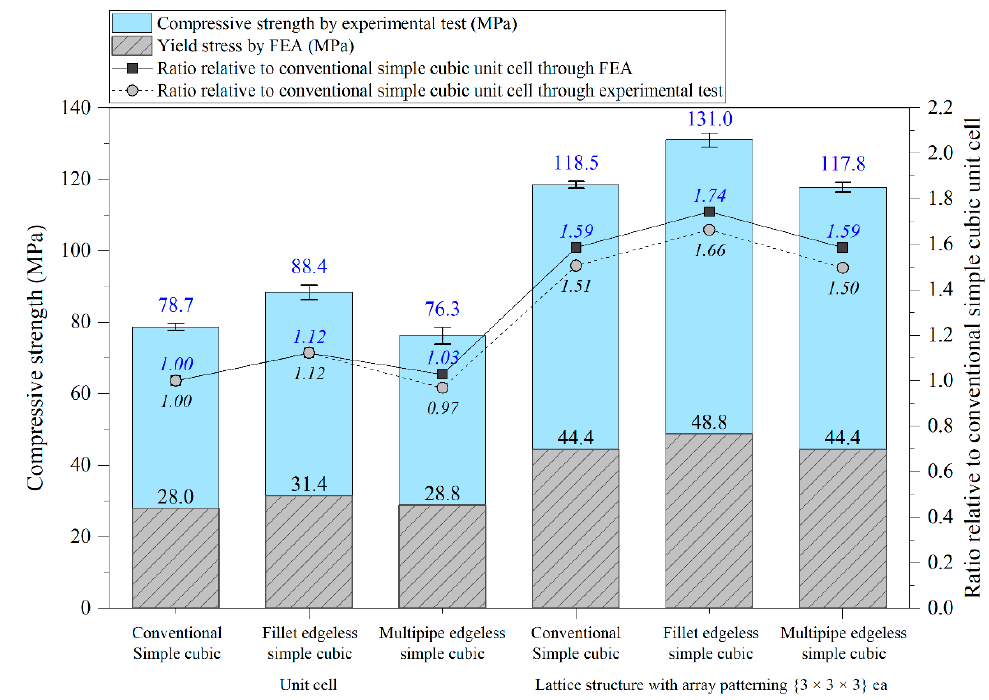
Figure 20. Compressive strength of optimized edgeless simple cubic la tt ice